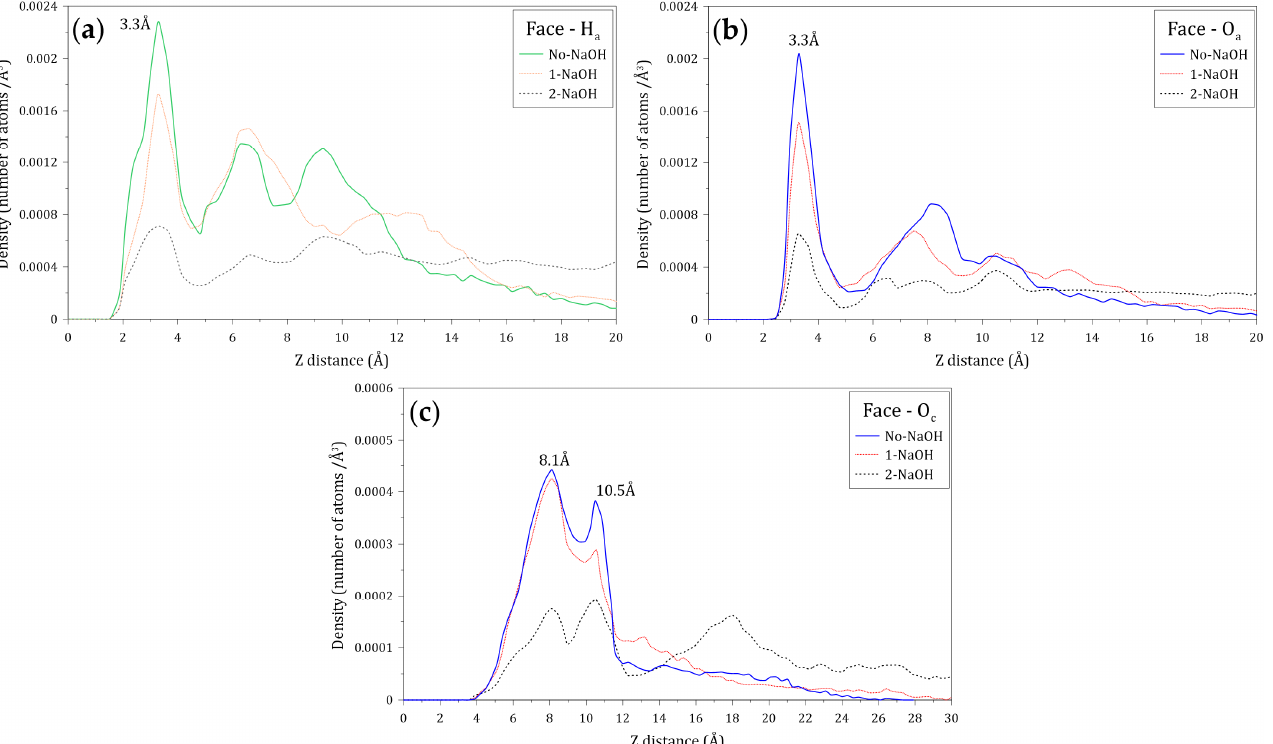
Figure 12. Snapshots of the mineral edge/HPAM interfaces: ( a ) No-NaOH, t = 0.1 ns; ( b ) No-NaOH, t = 10.0 ns; ( c ) 1-NaOH, t = 0.1 ns; ( d ) 1-NaOH, t = 10.0 ns; ( e ) 2-NaOH, t = 0.1 ns; ( f ) 2-NaOH, t = 10.0 ns. Na + , Cl − , and OH − ions are not shown to facilitate the visualization of HPAM molecules.